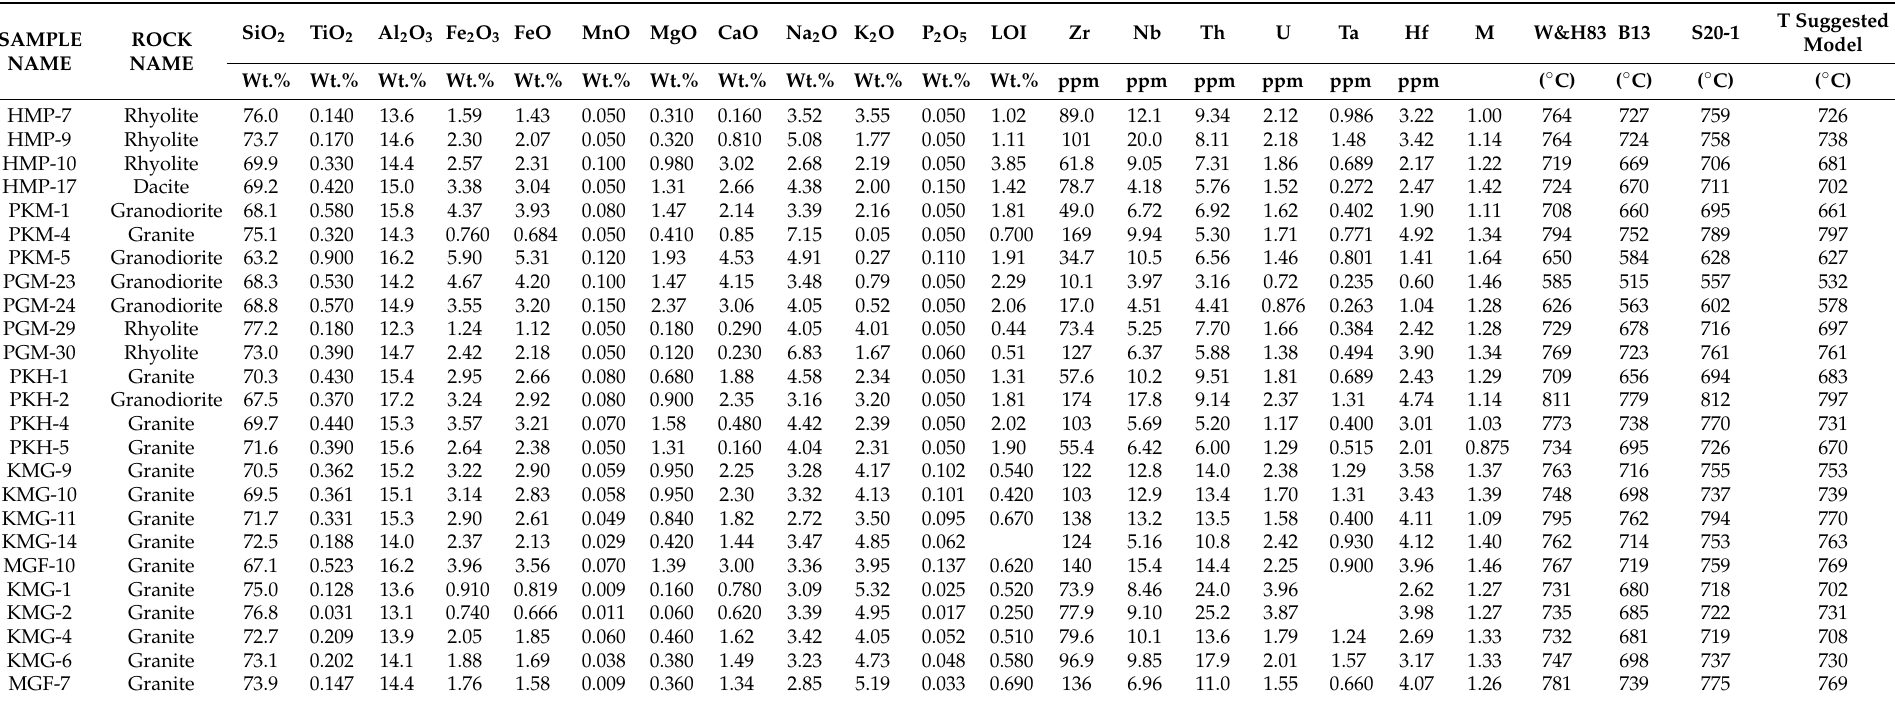
Table 1. Chemical composition of 18 selected peraluminous granite in southern Saqqez, northeast of Iran [69,70]. Temperatures are estimated from the revised T Zr (temperature of zircon saturation) by Watson and Harrison [18], Boenke et al. [19] and Shao [36] and suggested model for metaluminous and peraluminous rocks